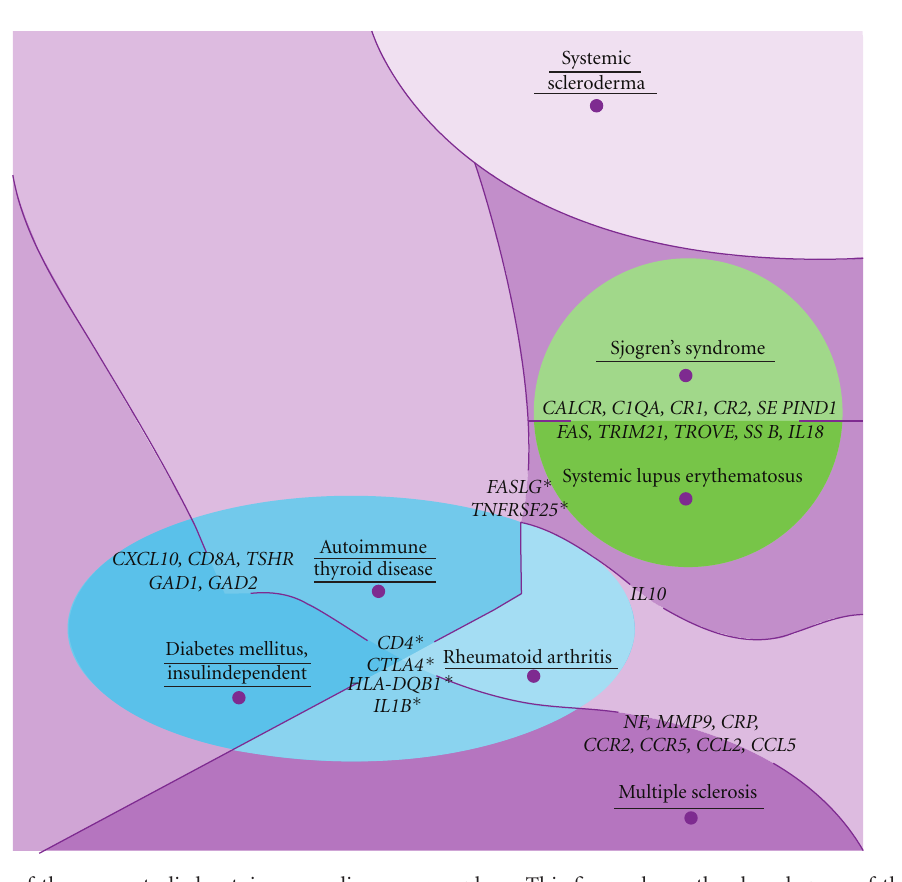
Figure 4: Projection of the seven studied autoimmune diseases on a plane. This figure shows the shared space of the genetic concept profiles from the studied AIDs (underlined), according to the matching value of their genetic concept profiles. We can see the genes with a contribution to clustering higher than 0.2%, the asterisk indicates the genes shared by two